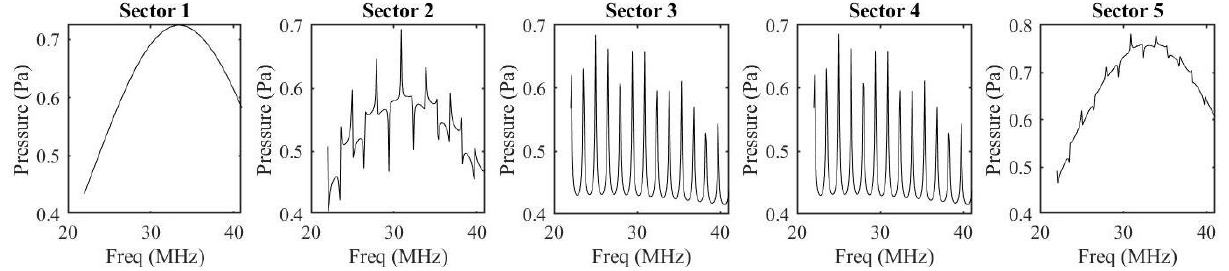
Figure 5. Frequency spectrum in different sectors at Z = 0.